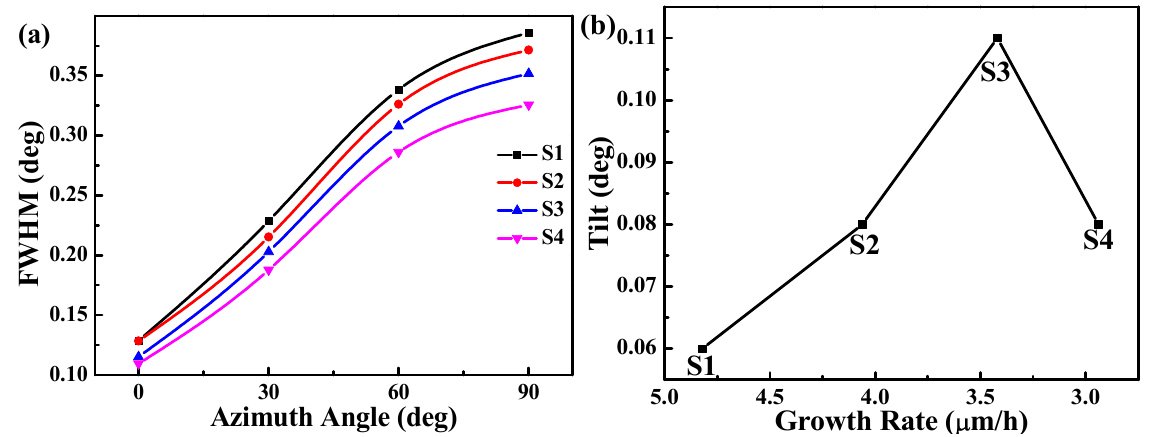
Figure 3. ( a ) On-axis XRC FWHM of GaN ω-scan as a function of azimuthal angle for all samples. ( b ) Tilt at different growth rate. Figure 4a,b show the RSMs around symmetric (11 2(cid:3364) 2) GaN on m -plane sapphire re- flection for sample S1 and S4 along directions [1 1(cid:3364) 00] and [ 11(cid:3364)(cid:3364)(cid:3364)(cid:3364) 23], respectively. Almost no